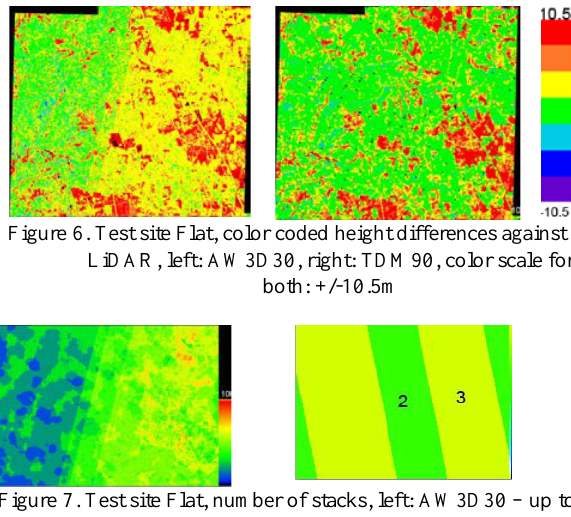
Figure 7. Test site Flat, number of stacks, left: AW3D30 – up to 10 covers, right: TDM90 with 2, respectively 3 covers